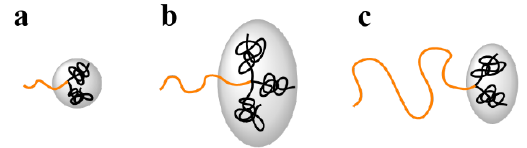
Figure 7. Schematics of i PP/ a PS miktoarm star copolymers with different lengths of soluble a PS arms in selective solvent DMF: ( a ) S-1, ( b ) S-2, and ( c ) S-3. Comparing S-2 (P 3 S 1 ) and S-4 (P 2 S 2 ), which possessed approximately equal overall molecular